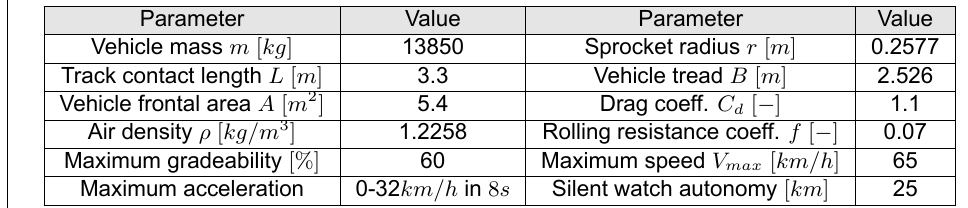
Table 1 – Overview of the vehicle parameters Таблица 1 – Обзор характеристик машины Табела 1 – Преглед параметара